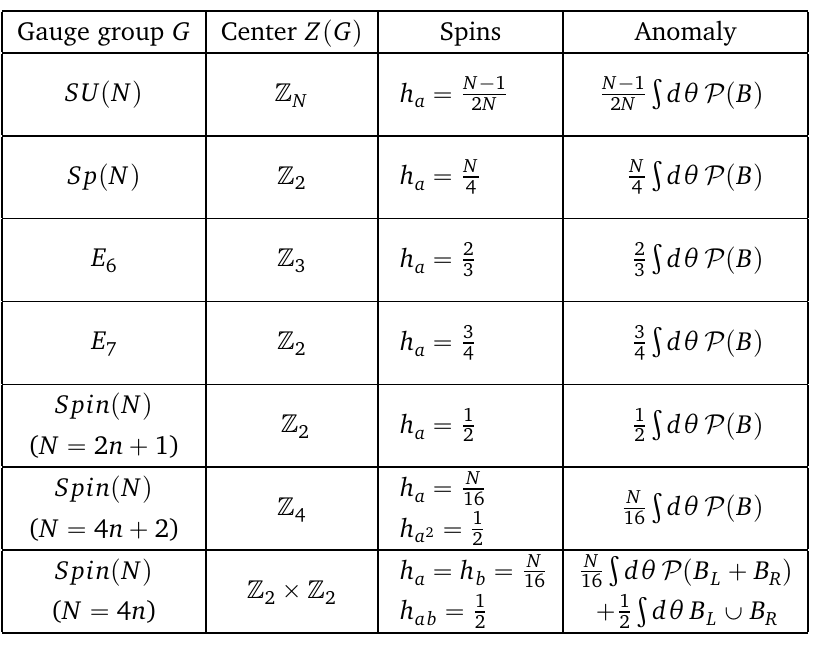
Table 3: Summary of the center one-form symmetries and the spins of the generating lines in various 3 d Chern-Simons theories. (See the discussion in [ 37 ] .) Here the gauge group is G and the level is k “ 1, i.e. this is the TQFT G . When the center is 1 (cid:96) ´ 1 u generated by the generating line a . When (cid:90) (cid:96) , the symmetry lines are t 1, a , ¨¨¨ , a ˆ (cid:90) the center is (cid:90) , the symmetry lines are t 1, a , b , ab u . The spins of these lines are 2 2 denoted by h , h and h . In the case Spin p N q with N “ 2 mod 4 we also included a b ab the spin of the line a 2 , which is used in the text. Note that in the context of 3 d TQFT only the spin h modulo one is meaningful. The values in the table are those of the conformal dimensions of the corresponding Kac-Moody